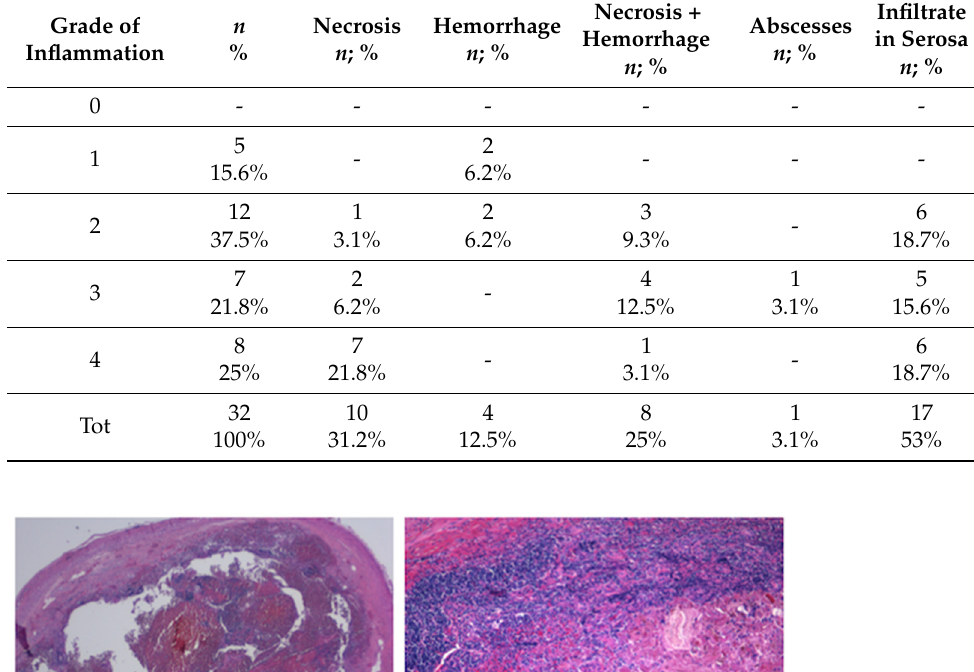
Table 1. Histopathologic features of appendices at the time of interval appendectomy.